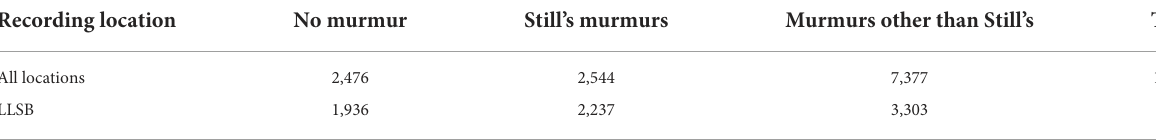
TABLE 5 Number of cardiac cycles recorded, by location and diagnostic category.